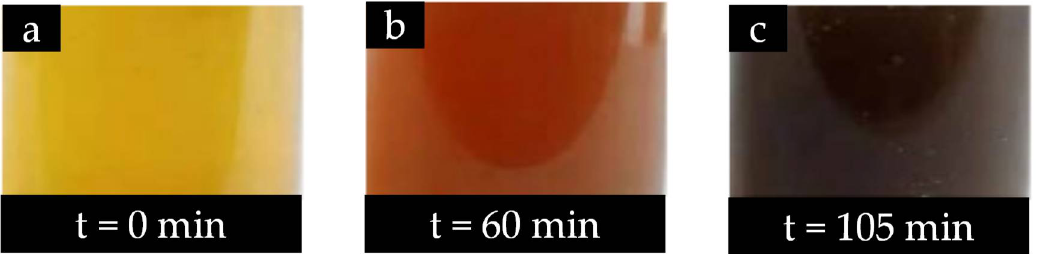
Figure 4. Colour change over time during the reaction between Citrus reticulata peel extract and CuSO 4 .5H 2 O at ( a ) 0 min, ( b ) 60 min and ( c ) 105 min. Adapted with permission from Ref. [186]. 2020, Elsevier.